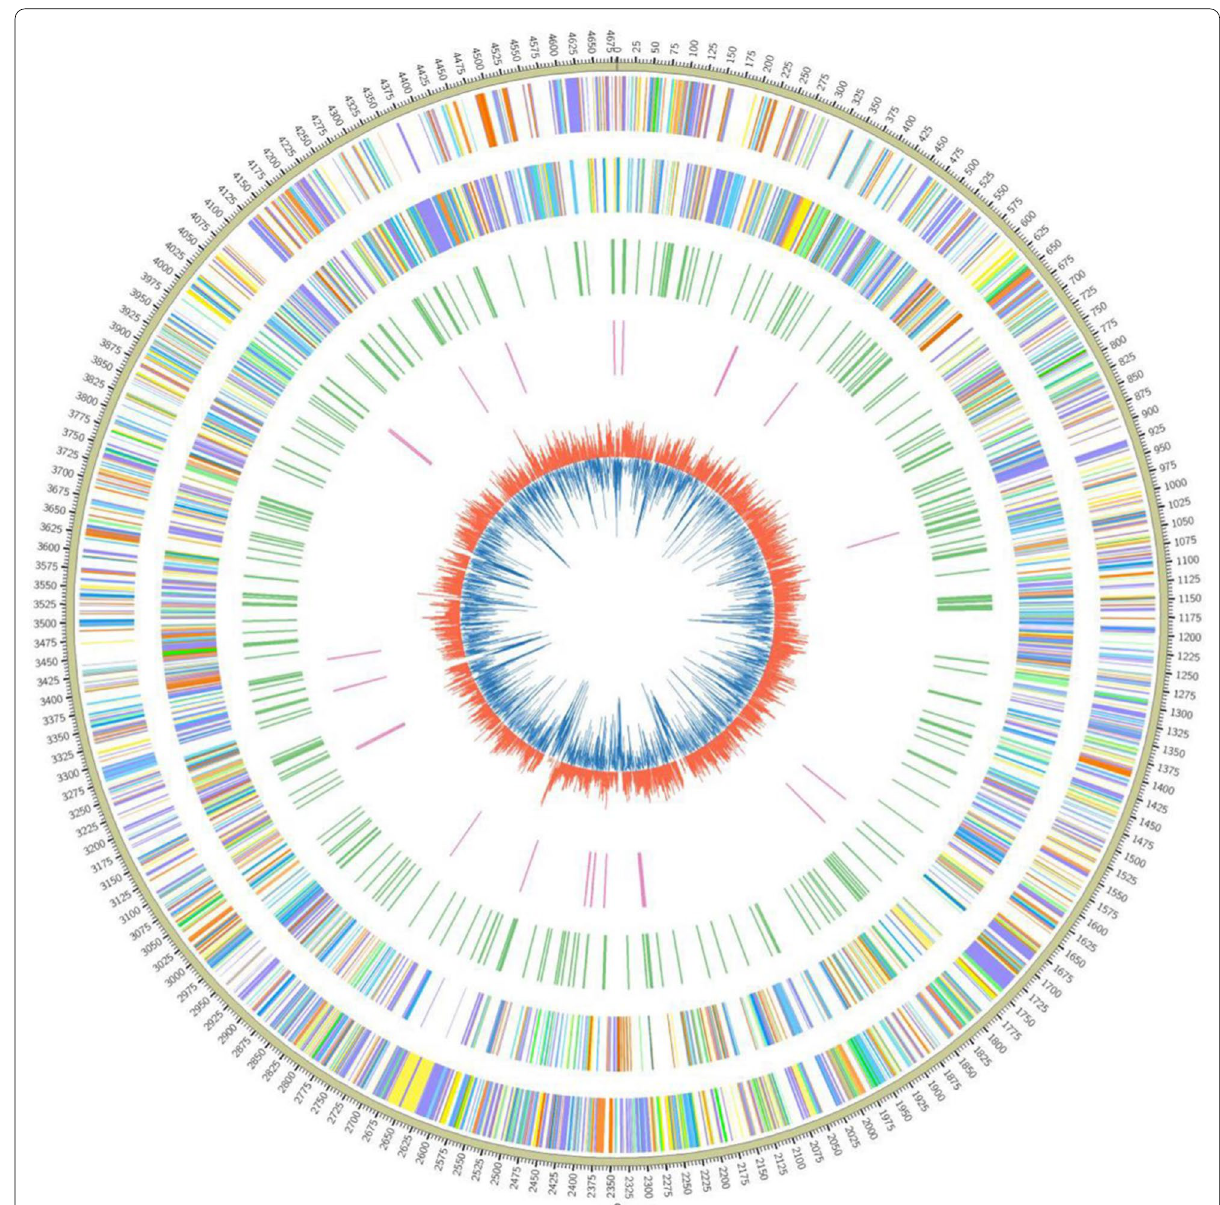
Fig. 4 Genome sequence of Microbulbifer sp. ALW1. The outermost circle is the mark of genome size, and each scale is 0.1 MB. The second and third circles are genes on the positive and negative chains of the genome respectively. Different colors represent different cog functional classifications. The fourth circle is the repeat sequence. The fifth circle is tRNA. The innermost layer is the GC content. The red part indicates that the GC content in this region is higher than the average GC content of the genome. The higher the peak, the greater the difference from the average GC content. The blue part indicates that the GC content in this region is lower than the average GC content of the genome. 0 represents the conting